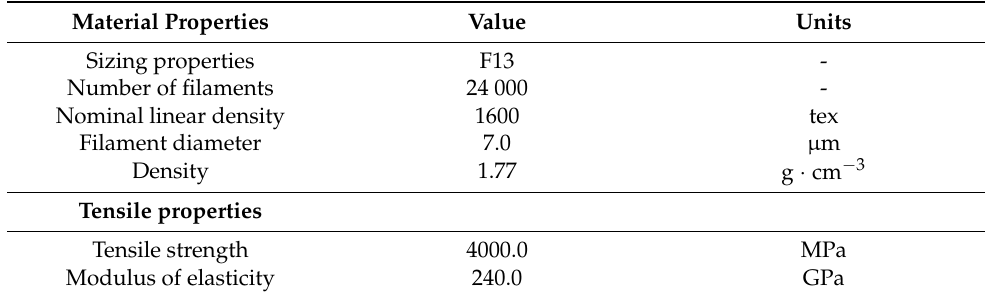
Table 2. Material data of carbon roving